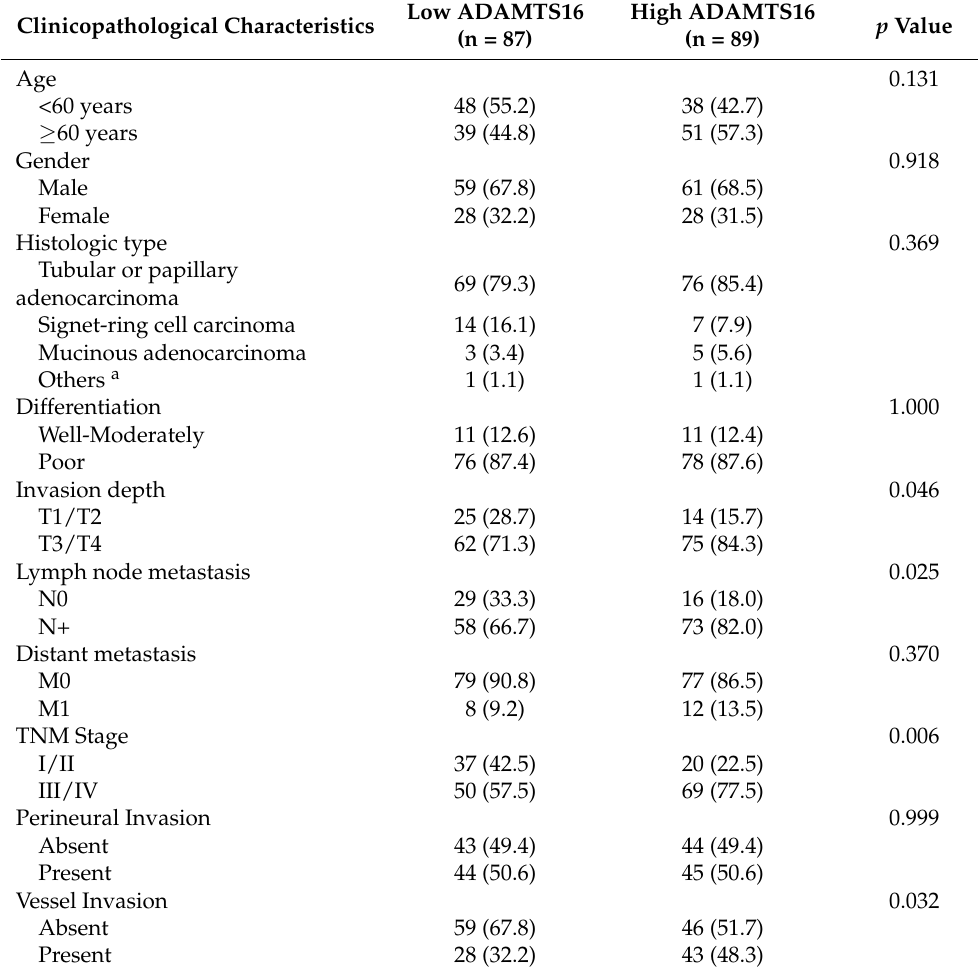
Table 1. Correlation between the expression of ADAMTS16 and clinicopathological characteristics of GC patients (n =